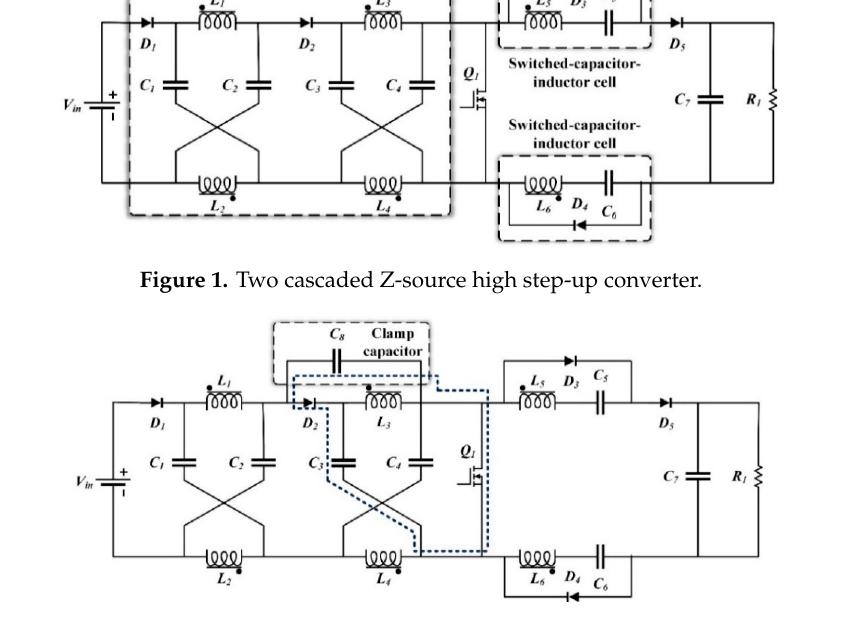
Figure 2. Modified converter by a clamp capacitor.